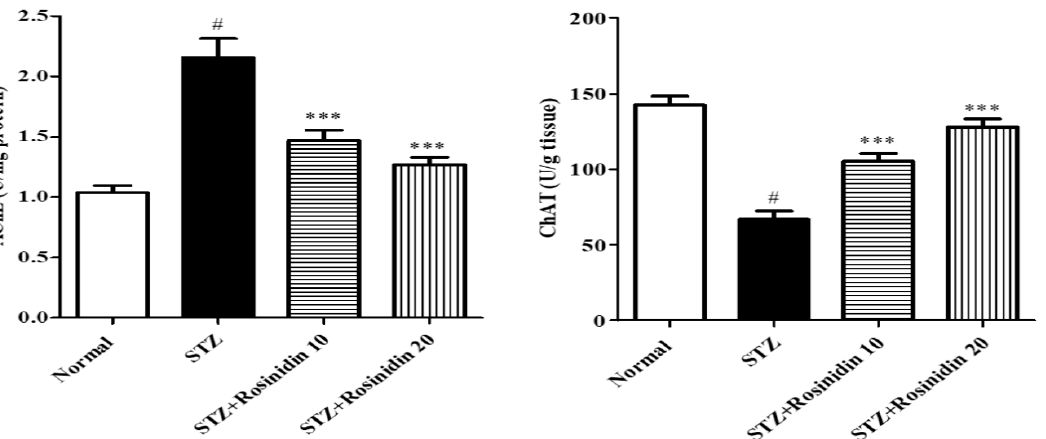
Figure 4. The effect of rosinidin on AChE and ChAT activity. All the values are presented as the mean ± SEM. Correlation among the groups was done using Tukey’s test by one-way ANOVA. p -value < 0.001 were expressed as *** respectively as compared with the streptozotocin (STZ) group. # significant as compared with the controls ( p < 0.001).